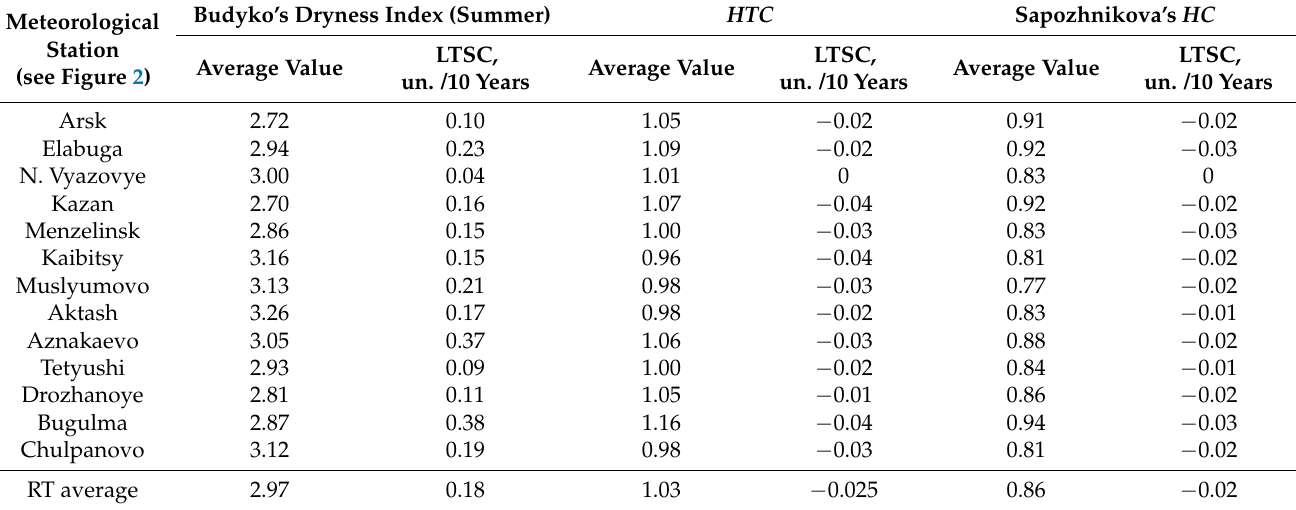
Table 8. Changes in air humidity indicators in the Republic of Tatarstan (RT), the Volga Federal District, during